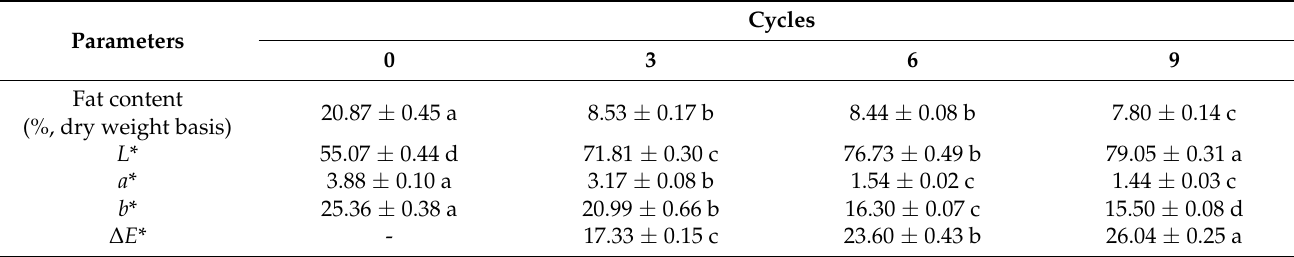
Table 2. Fat content and color of hydrolyzed collagen without and with fat removal using disk stack centrifugal separator (DSCS) for different centrifugal